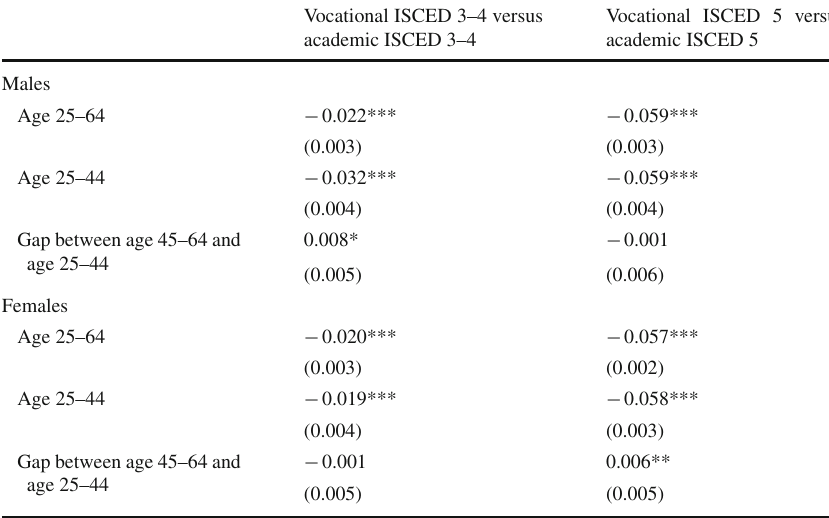
Table2 Aggregatedaveragetreatmenteffects.Dependentvariable:logliteracyscore. Source :Calculations based on PIAAC data Vocational ISCED 3–4 versus academic ISCED